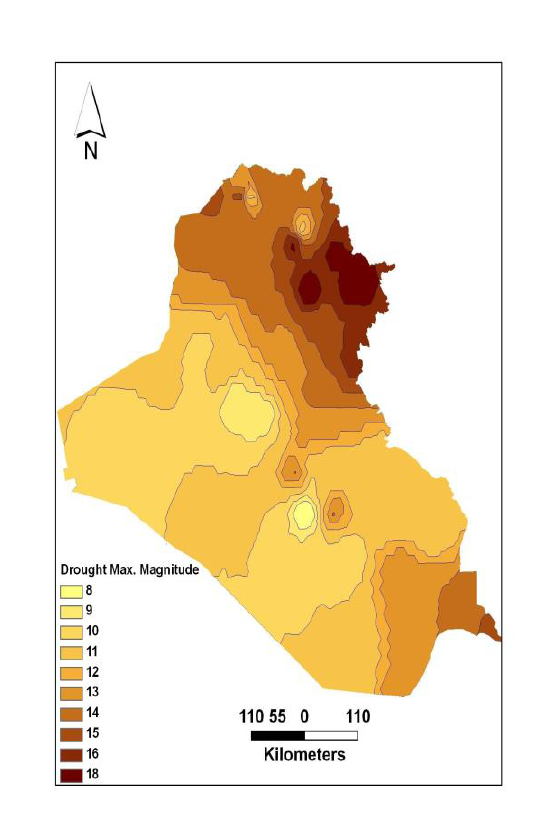
Fig. 5: Map of drought Magnitude for 30 years